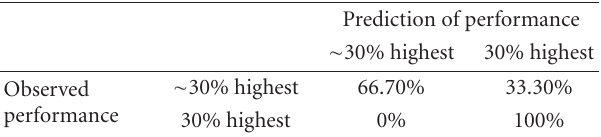
Table 3: Testing phase of the neural network predicting highest 30% math